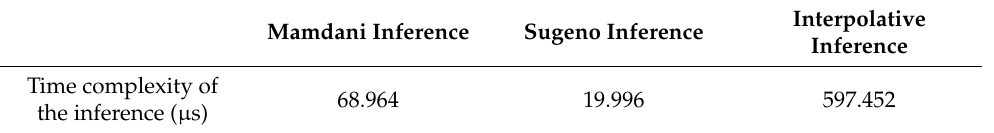
Table 4. Comparison of the time complexities of different fuzzy control models.